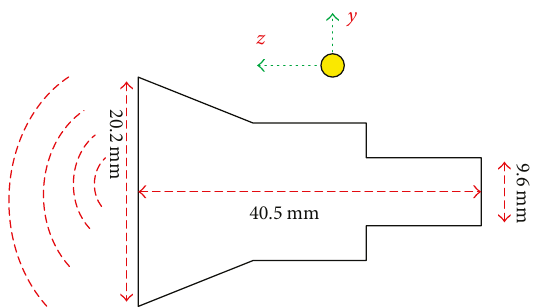
Figure 2: A Ka-band conical horn model used as a feed in the proposed 3D printed re fl ector